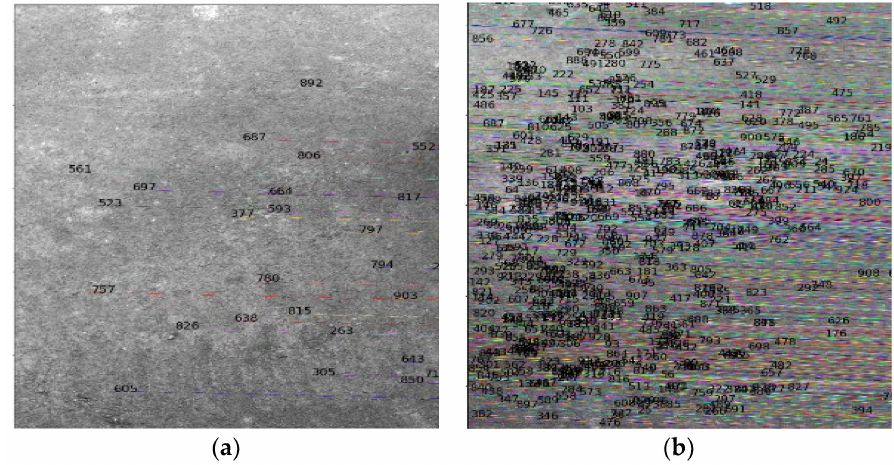
Figure 8. Illustration: ( a ) sea surface base plane calibration image 1; ( b ) sea surface base plane calibration image 2.